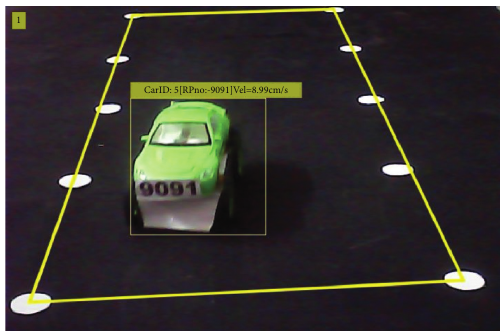
Figure 23: Frame showing the successful detection and recognition of the number plate at an optimum distance from the cameras’